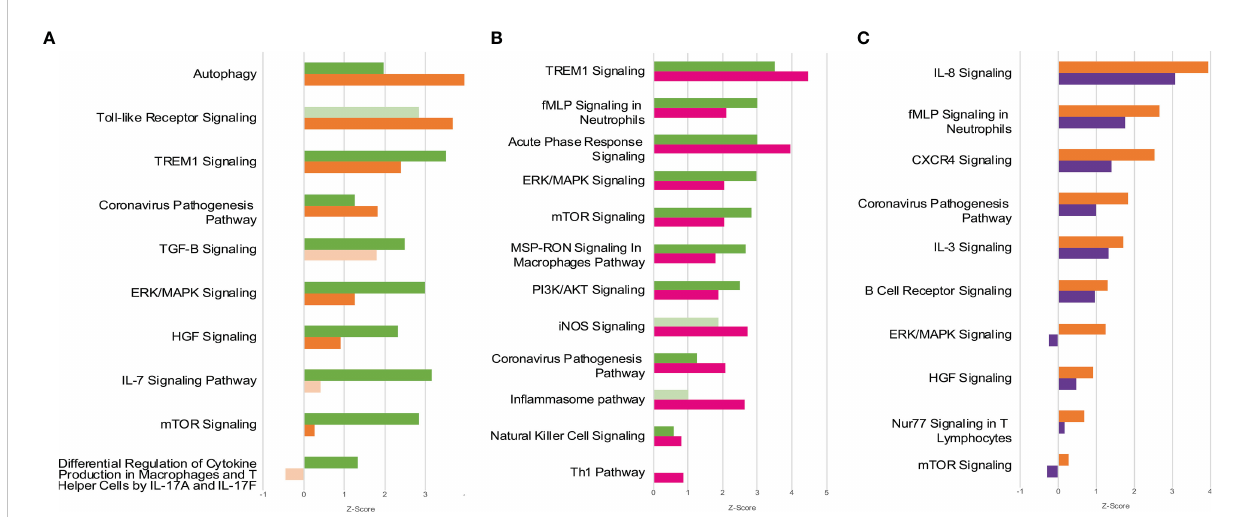
FIGURE 6 Canonical Pathways affected by COVID-19 and B12. Patients with moderate and severe COVID-19 previously treated with glucocorticoids had distinct global gene expression patterns (A) and vitamin B12 attenuated the pro-in fl ammatory pro fi le of leukocytes from patients with moderate (B) or severe (C) forms of the disease. Green bars = contrast 1 (MOD vs. CTRL at endpoint A); Orange bars = contrast 2 (SEV vs. CTRL at endpoint A); Pink bars = contrast 3 (MOD at endpoint B vs. CTRL at endpoint A); Purple bars = contrast 4 (SEV at endpoint B vs. CTRL at endpoint A); Faded bars indicate pathways with P value greater than 0.05 (statistically non-signi fi cant). SEV, severe COVID-19; MOD, moderate COVID-19. Suf fi xes: A, endpoint A (Samples added to culture medium with excipient and incubated for 24h); B, endpoint B (Samples added to culture medium with B12 and incubated for